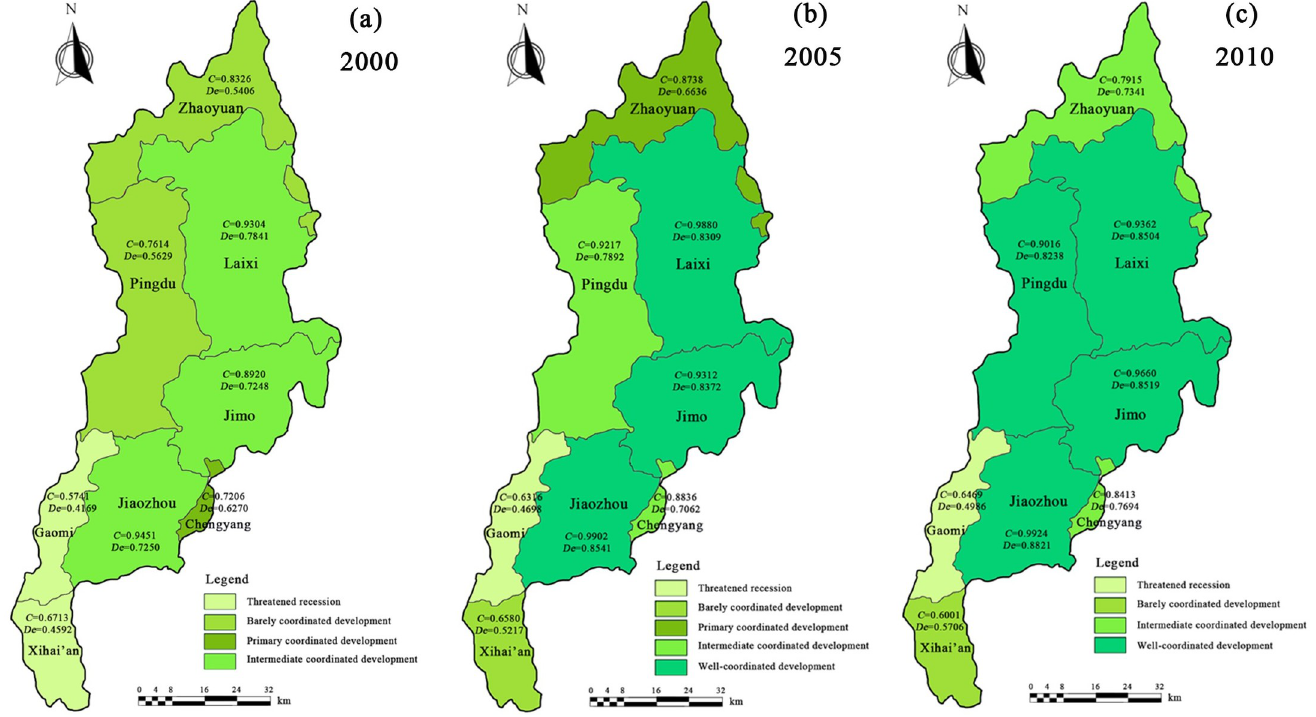
Fig 4. Coupling coordination results for the ecosystem services and water and land resource utilization for different spatial districts.